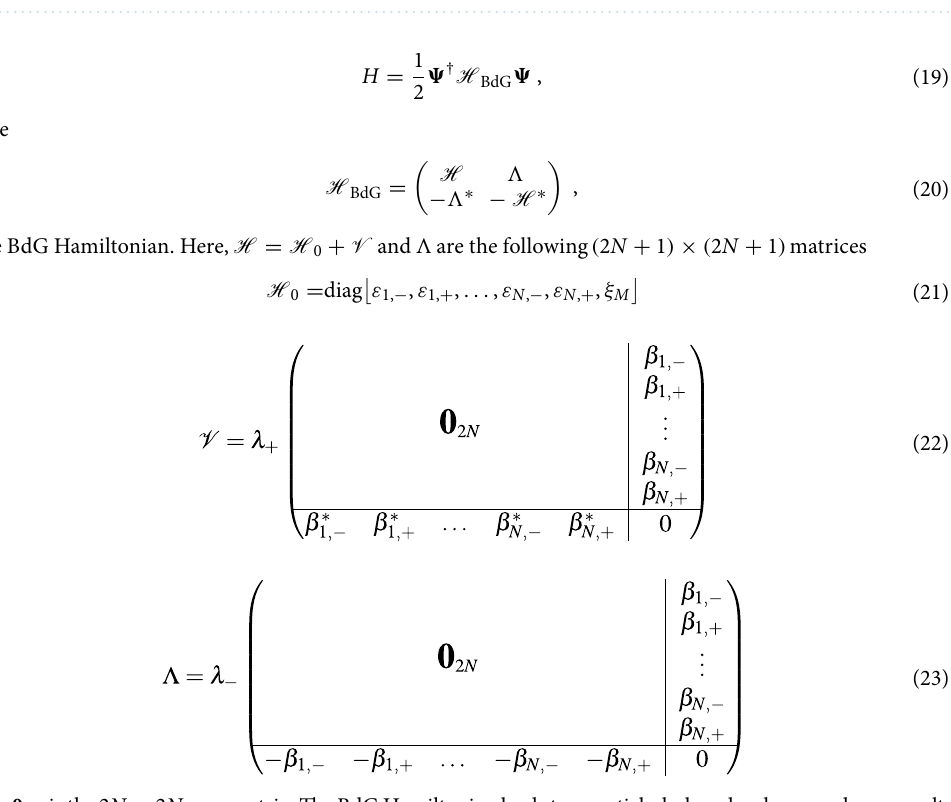
Figure 2. Quasiparticle spectra for (cid:31) 1 = 0.1 and (cid:31) 2 = 0 . The number of sites, N , the coupling between MZMs, ξ M , and the Rashba spin-orbit coupling, α , are indicated in the figure. Black curves represent the states in the quantum ring and the red curves correspond to the Majorana